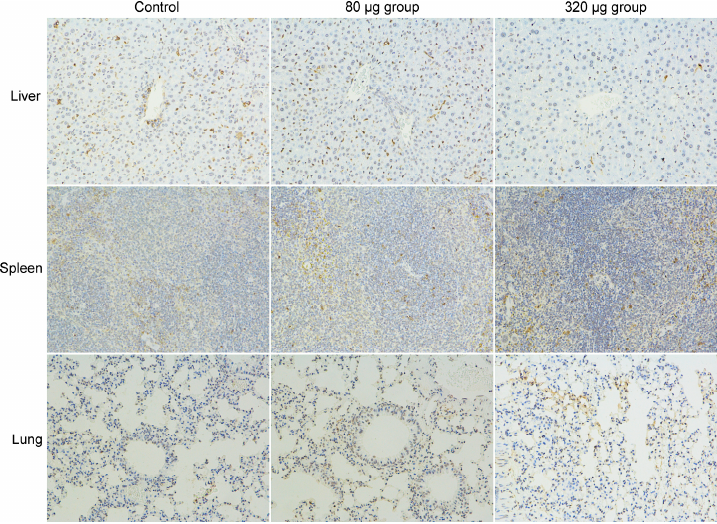
Figure 5. Apoptosis analyses of the mice exposed to CNSI at 28 days post intravenous exposure by the terminal deoxynucleotidyl transferase-mediated dUTP nick-end labeling (TUNEL) method (200×).